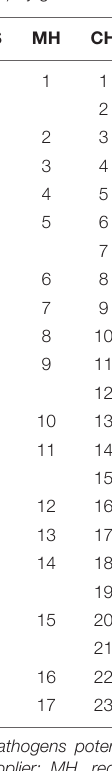
TABLE 1 | Counts and reported vaccination protocols 1 for contemporary groups (CG) by genetic supplier (GS).